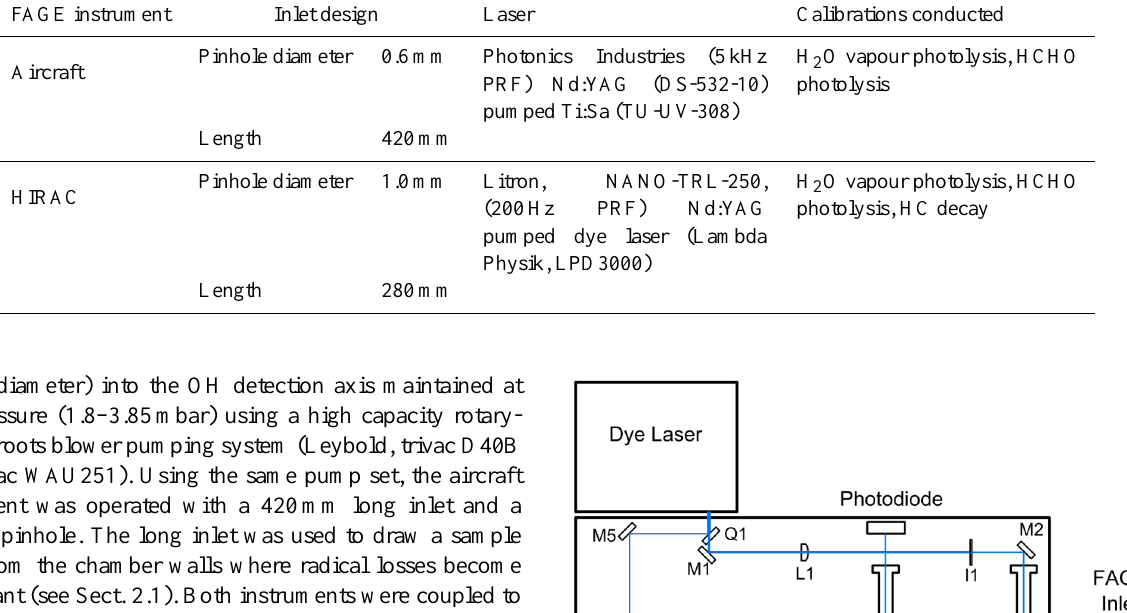
Table 1. FAGE instruments used and their respective inlet designs, laser systems and calibration methods used. FAGE instrument